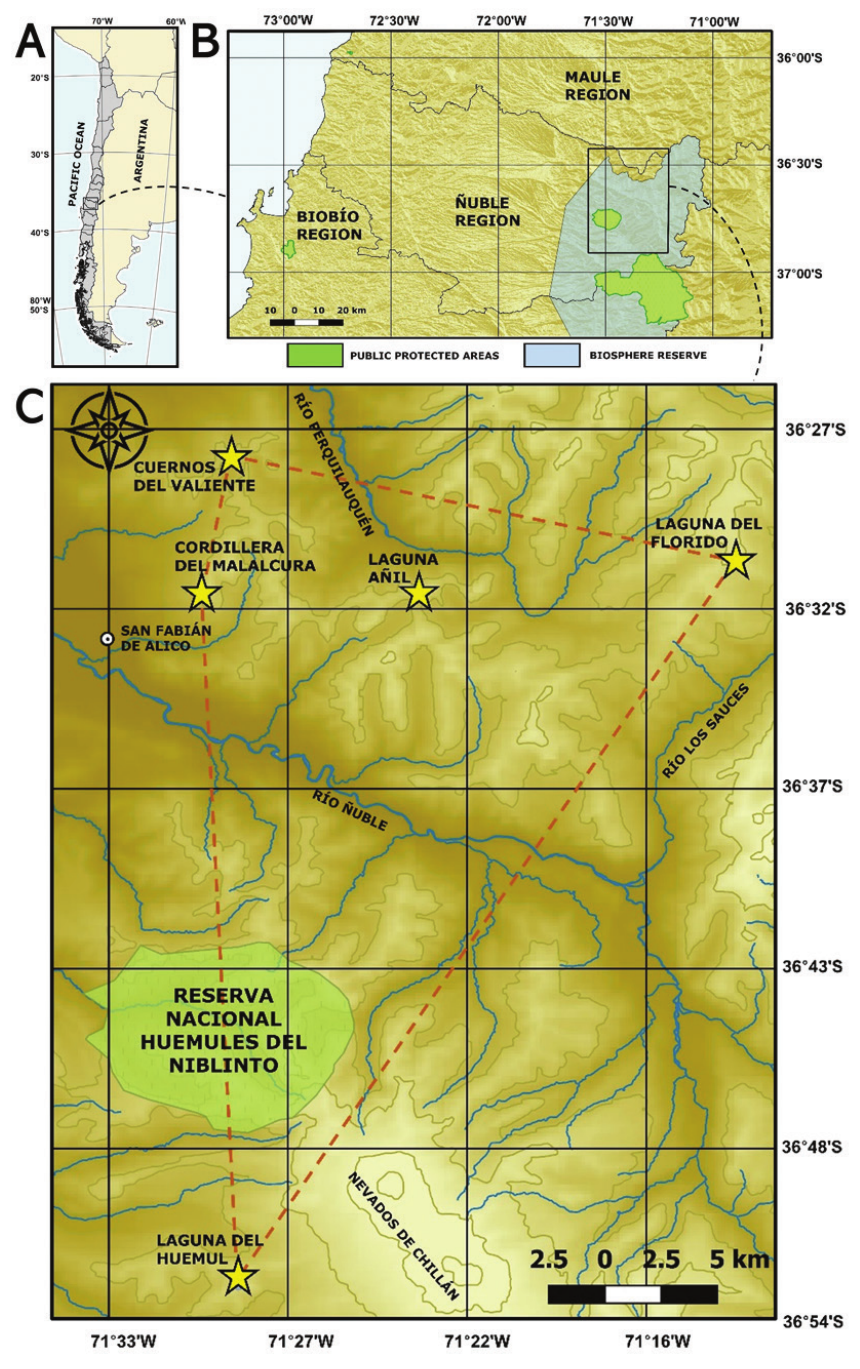
Figure 1. Distribution maps of Valeriana praecipitis A Chile B Ñuble Region C s ites of V. praecipitis (yellow stars) and extent of occurrence (red